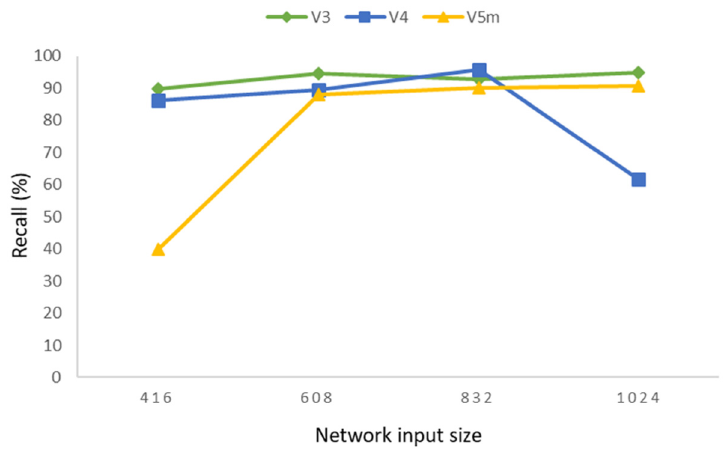
Figure 9. Comparison of the recall values of YOLOv3, YOLOv4, and YOLOv5m.